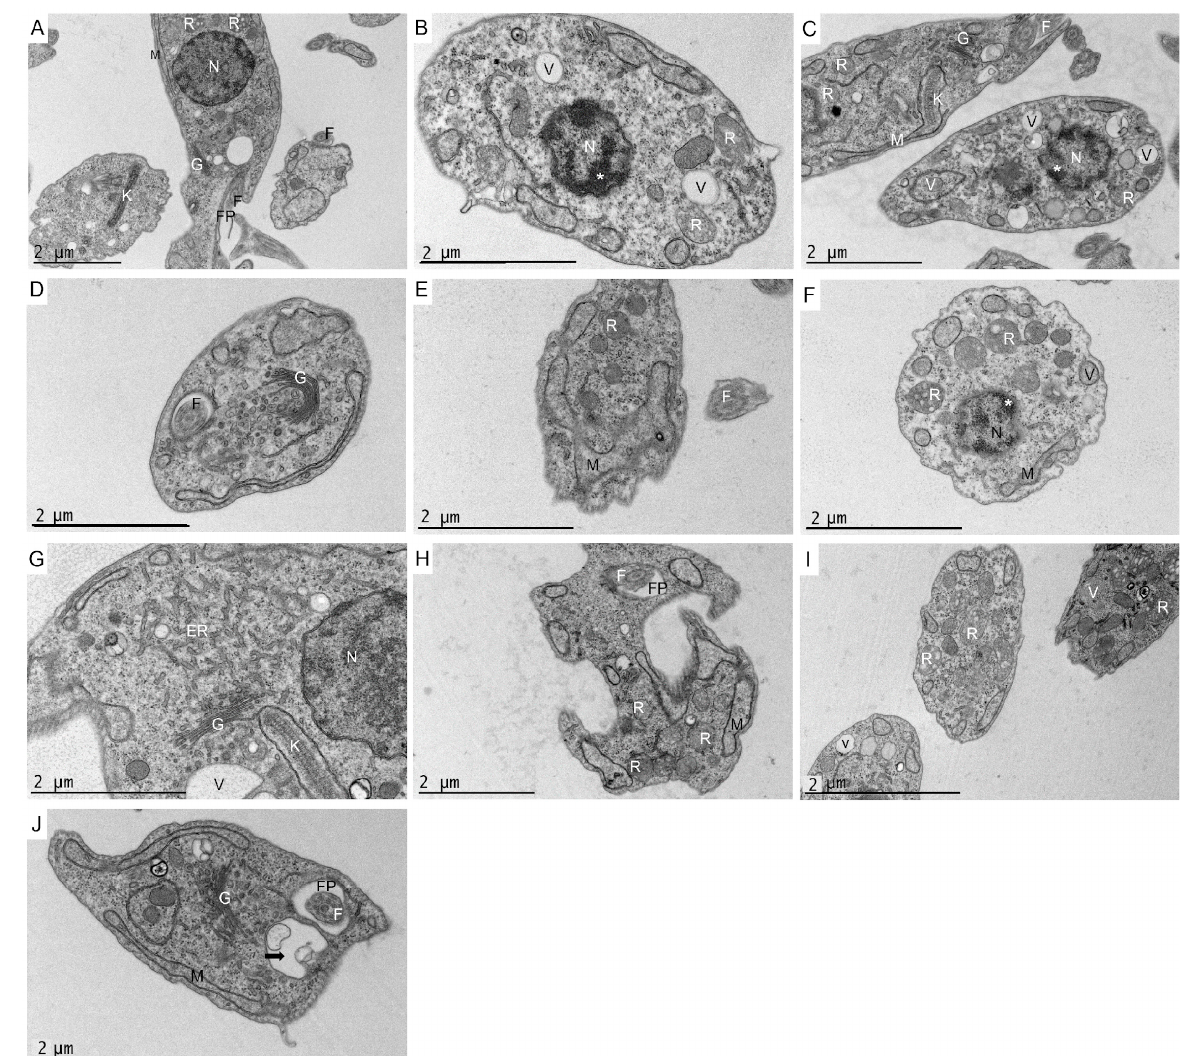
Figure 6. Transmission electron microscopy of T. cruzi epimastigotes after 24 h of incubation at the IC 90 levels of gongolarone B, 6 Z -1 (cid:48) -methoxyamentadione and 1 (cid:48) -methoxyamentadione. The control parasite (image ( A )) showed its characteristic elongated body and normal morphology of the nucleus (N), mitochondrion (M), kinetoplast (K), Golgi (G), reservosomes (R), flagellum (F) and flagellar pocket (FP). Similar ultrastructural damage and a discontinuity of the parasite cytoplasm can be observed in T. cruzi epimastigotes after incubation with gongolarone B (images ( B – D )), 6 Z -1 (cid:48) - methoxyamentadione (images ( E – G )) and 1 (cid:48) -methoxyamentadione (images ( H – J )). These compounds caused morphological mitochondrial (M) and kinetoplast (K) alterations, chromatin condensation in the nucleus (*), intense vacuolization (V) and the formation of some autophagy vacuoles (black arrows). All three compounds caused an increase in reservosomes in the cytoplasm. The Golgi (G) and endoplasmic reticulum (ER) were also found to be overdeveloped (with more vacuoles and cisternae than the control). The characteristic morphology and size of the epimastigotes was also altered after incubation with the pure